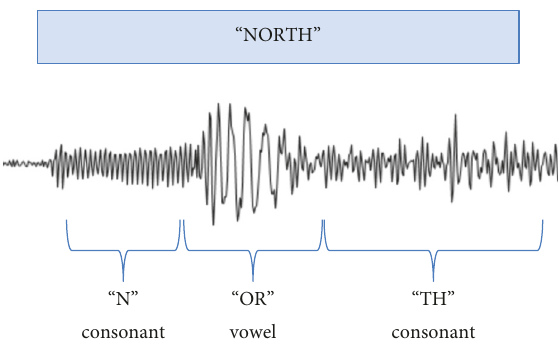
Figure 3: The pronunciation waveform of the word North.